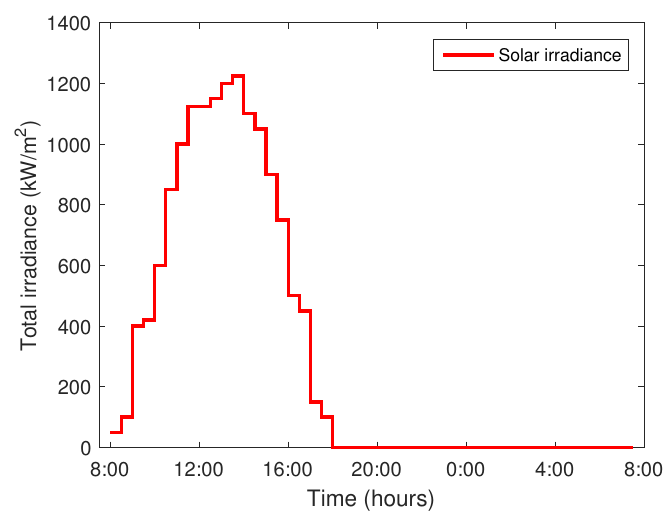
Figure 6. Estimated solar